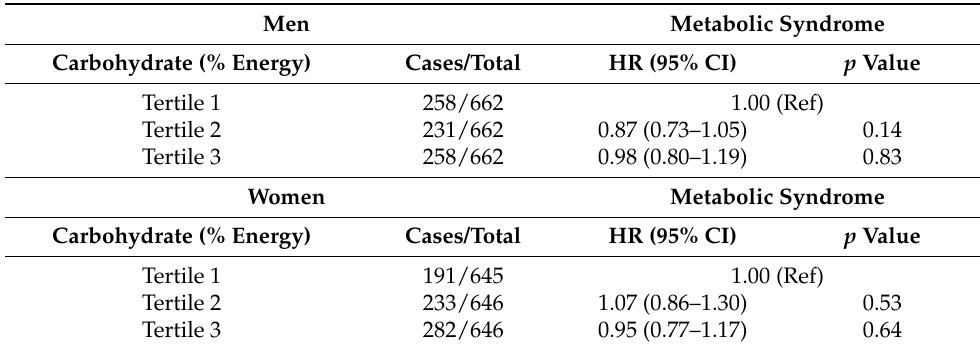
Table 6. Adjusted hazard ratios (HRs) and 95% confidence intervals (CIs) of metabolic syndrome incidence depending on carbohydrate intake.